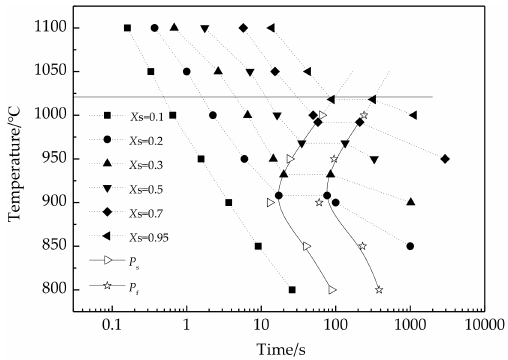
Figure 7. RPTT diagram of experimental